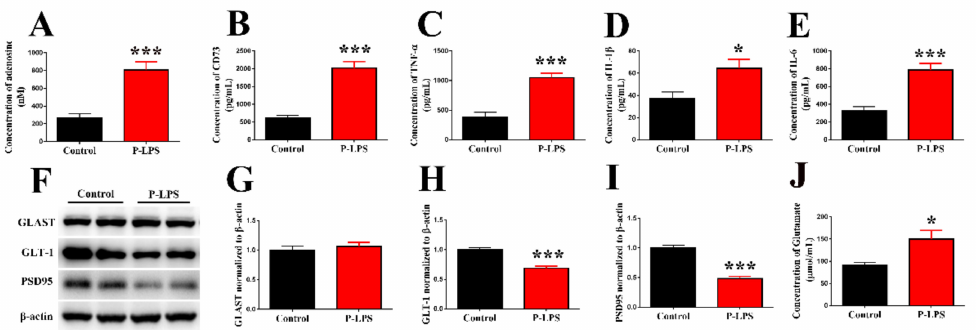
Figure 3. Effects of P. gingivalis LPS on the levels of inflammation factors, glutamate transporters and PSD95. The concentration of adenosine ( A ) was determined by fluorescence method. CD73 ( B ), TNF- α ( C ), IL-1 β ( D ) and IL-6 ( E ) in the hippocampus of mice were detected by ELISA. The levels of GLAST ( F , G ), GLT-1 ( F , H ) and PSD95 ( F , I ) in the hippocampus of mice were detected by Western blot. The concentration of glutamate ( J ) was detected by colorimetric enzyme method. All data are expressed as the mean ± SEM ( n = 6 per group). * p < 0.05 and *** p < 0.001 vs. the control